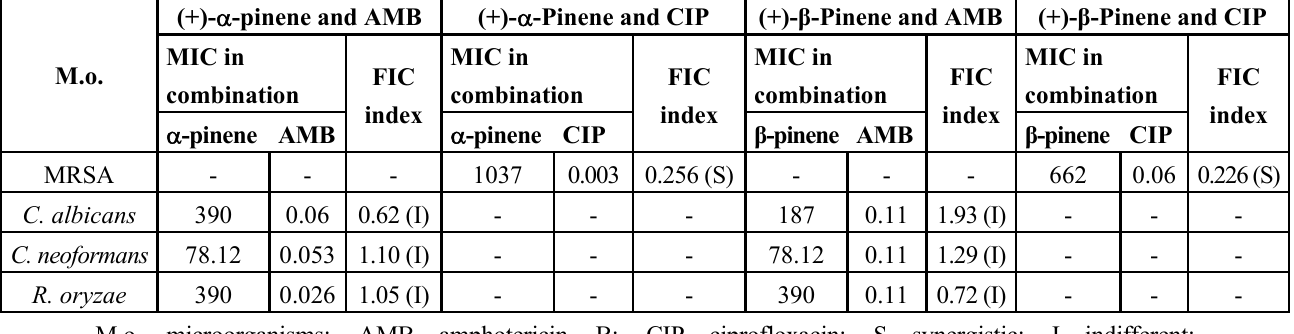
Table 2. Susceptibilities of microorganisms to antimicrobial drugs in combination with (+)-  -pinene and (+)- β -pinene standards (µg/mL).